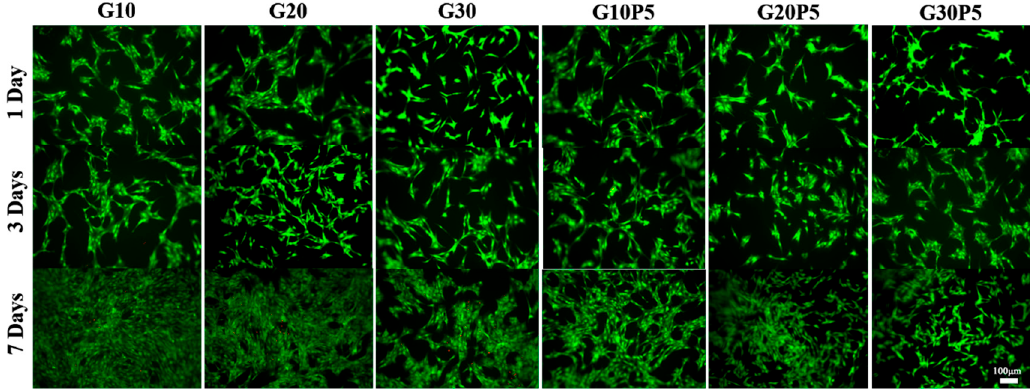
Figure 7. Live/dead staining of MC3T3-E1 cultured on the surface of hydrogel for 1 day, 3 days, and 7 days. (Green: Live cells; red: Dead cells).